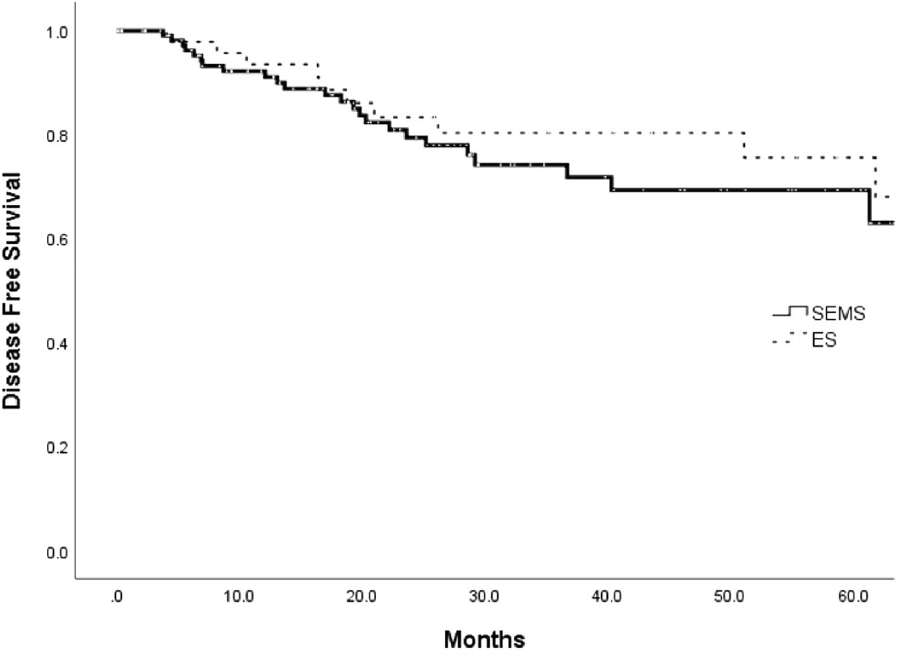
Figure 2. Disease-free survival between the SEMS and ES groups (5 years- 69.3% vs 75.6%, P = 0.233).